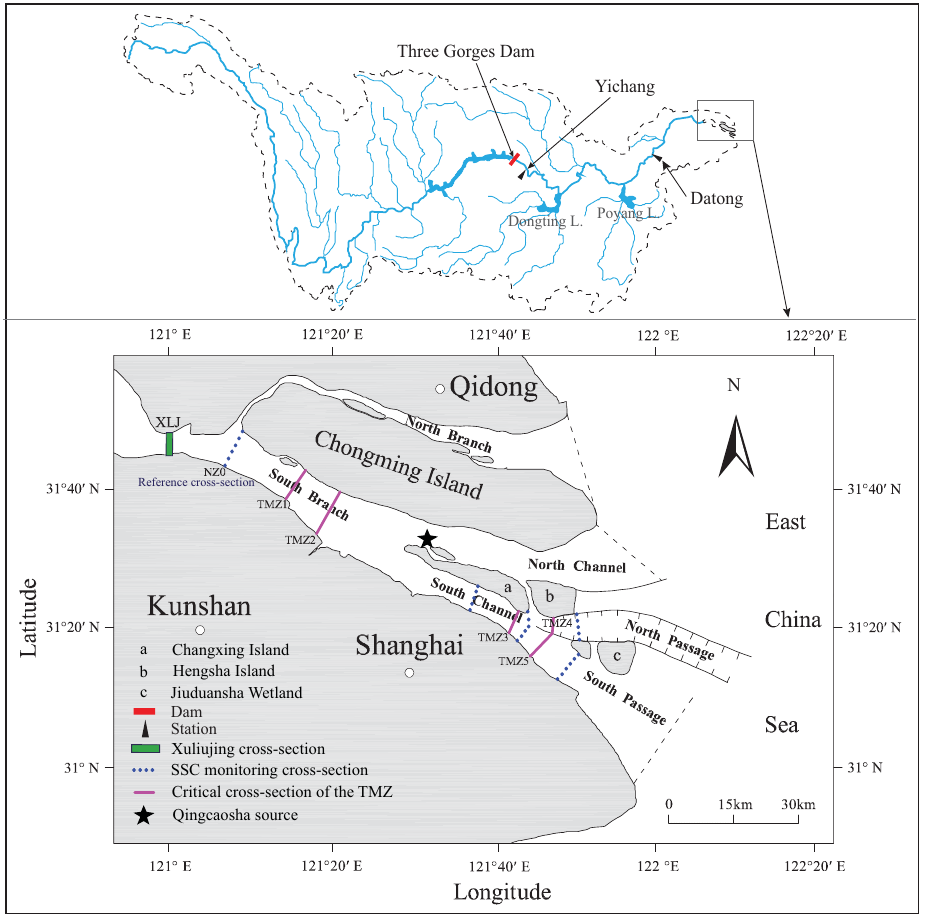
Figure 1. The Yangtze River Estuary (SSC refers to the suspended sediment concentration, TMZ refers to the turbidity maximum